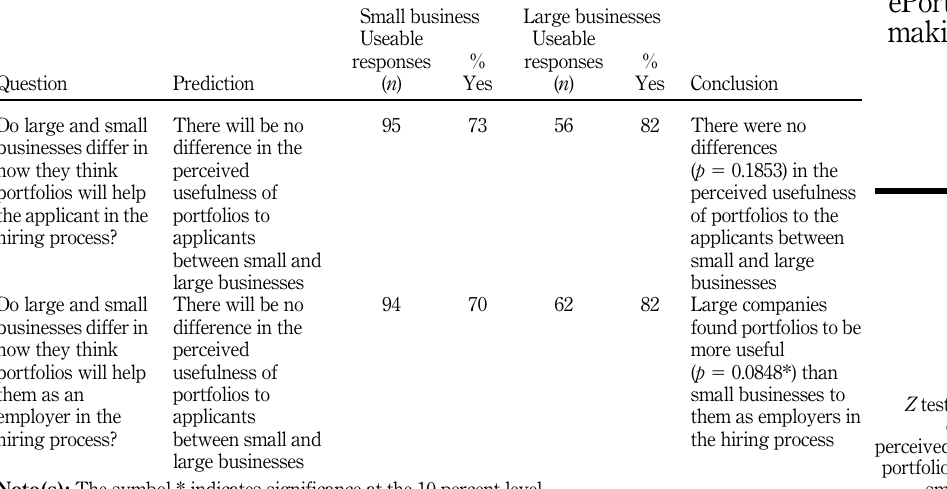
Table 5. Z test results of the